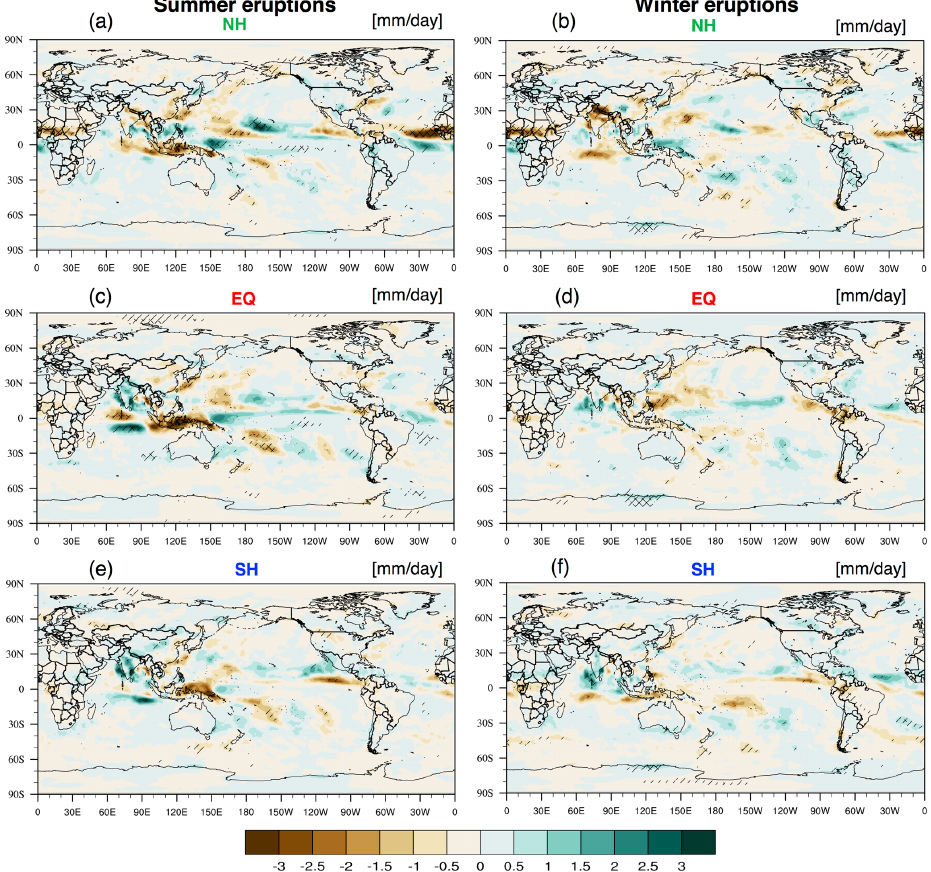
Figure 5. Spatial distribution of JJA mean precipitation (mmd − 1 ) anomaly in 1992 for the summer NH (a) , EQ (c) and SH (e) eruption cases and in 1991 for the winter NH (b) , EQ (e) and SH (f) eruption cases. The cross signs and slashes indicate the grid points with significant differences based on the two-tailed Student’s t tests at the 95% and 99% confidence level,